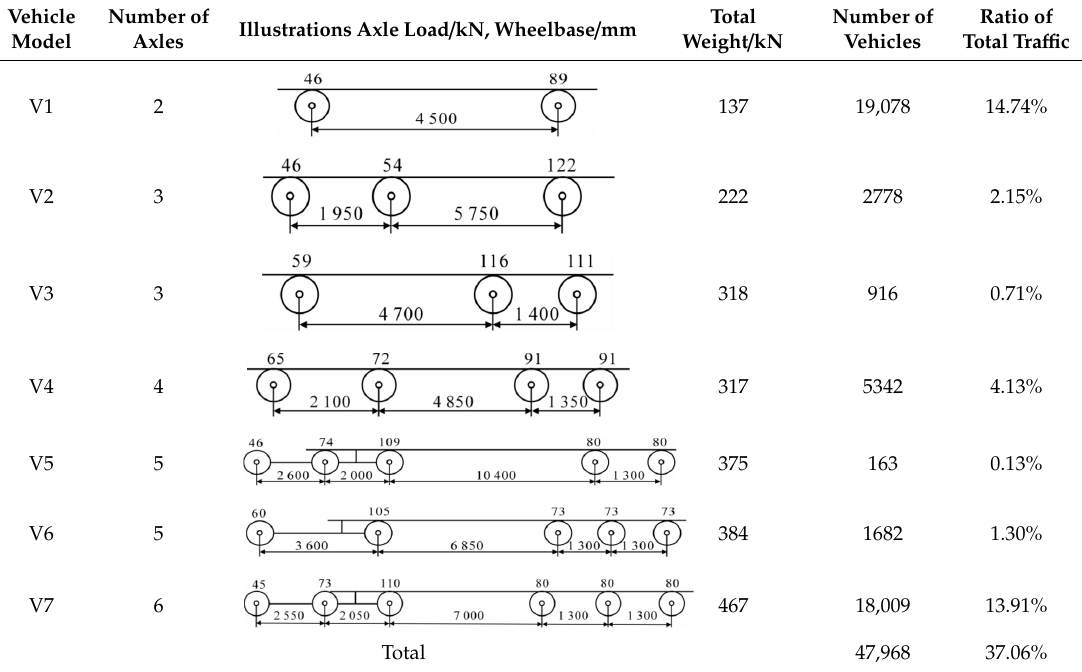
Table 8. Vehicle load frequency spectrum for the certain bridge (96 h).